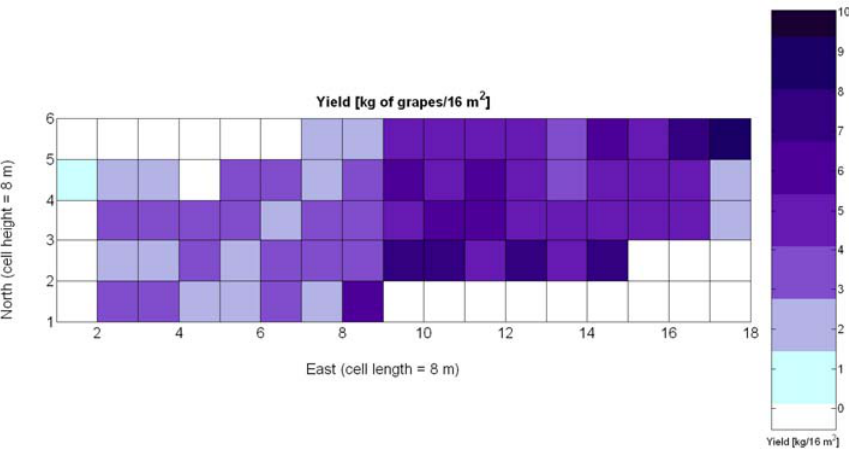
Figure 29. Low resolution CB map of grape yield (kg of grapes/16 m 2